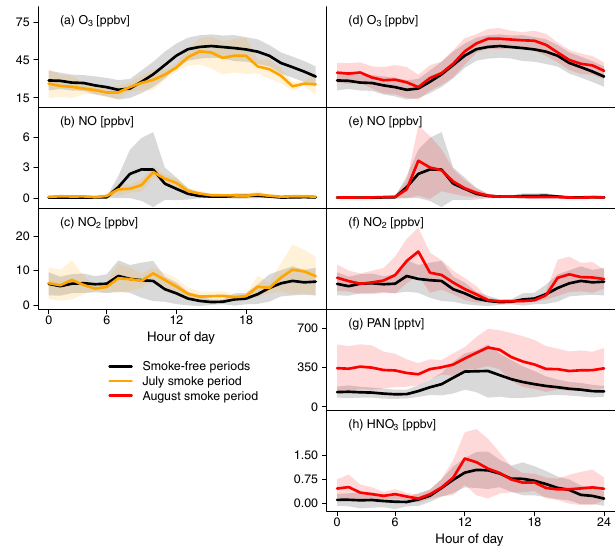
Figure 5. Average diurnal cycles in MDT of O 3 and oxidized re- active nitrogen species at BAO. Panels (a) , (b) , and (c) compare average diurnal cycles from smoke-free time periods (black) to average diurnal cycles from the July smoke-impacted period (or- ange). Panels (d) – (h) show average diurnal cycles during the Au- gust smoke-impacted period (red) to the same average diurnal cy- cles from smoke-free periods (black). Gray, orange, and red shad- ing indicates plus and minus 1 standard deviation. PAN and HNO 3 measurements were not available during the July smoke-impacted period. Solar noon on 1 July 2015 was at 13:03, solar noon on 7 September was 2015 was at